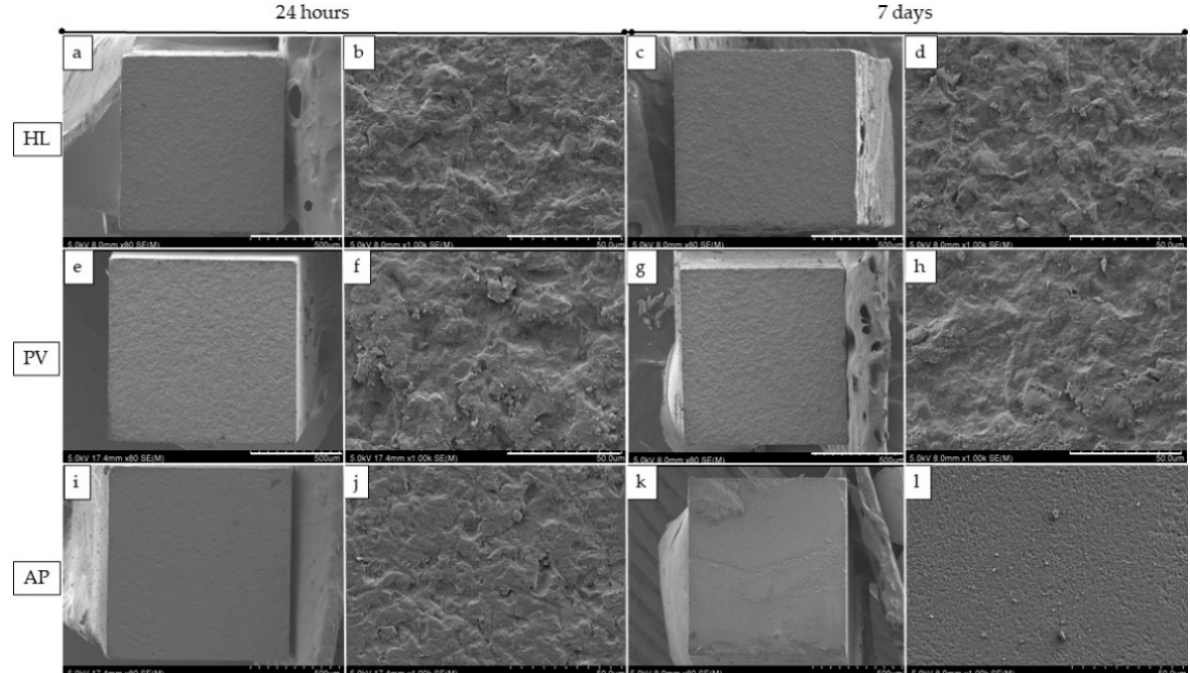
Figure 2. SEM images show the fractured dentin surface following the µTBS test (×80 and ×1000). HL, PV and AP represents the cohesive failure after 24 hours and 7 days. ( b , d , f , h , j , l ) represents higher magnification of ( a , c , e , g , i , k ) respectively.